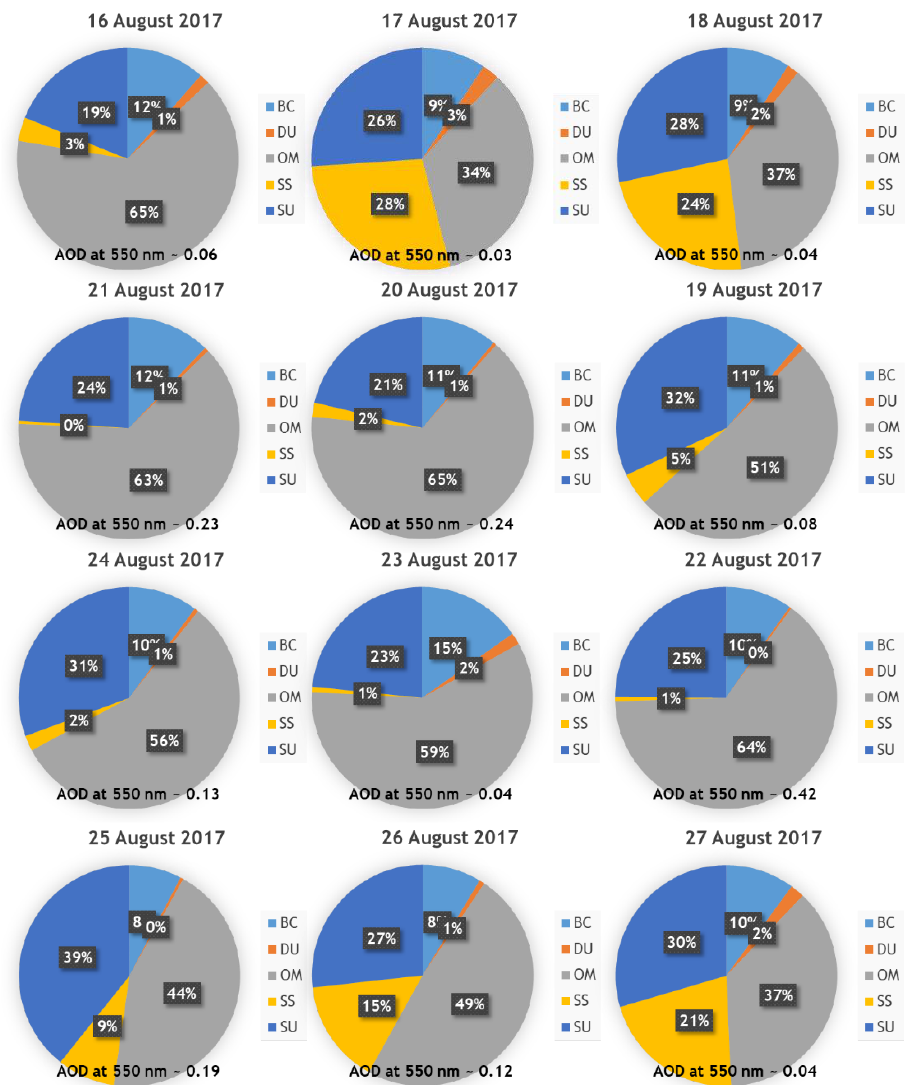
Figure14. Dailypercentageofeachchemicalcomponentat550nmAerosolOpticalDepthinNy-Ålesund Figure 14. Daily percentage of each chemical component at 550 nm Aerosol Optical Depth in Ny- between 16 and 27 August 2017 compared with Aerosol Optical Depth at 550 Å lesund between 16 and 27 August 2017 compared with Aerosol Optical Depth at 550 nm.